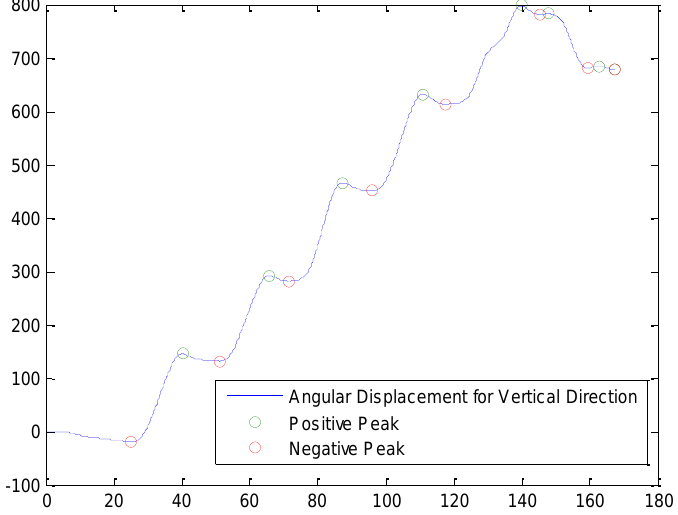
Figure 13. An example of turn detection from a gyroscope and a magnetic field sensory data.